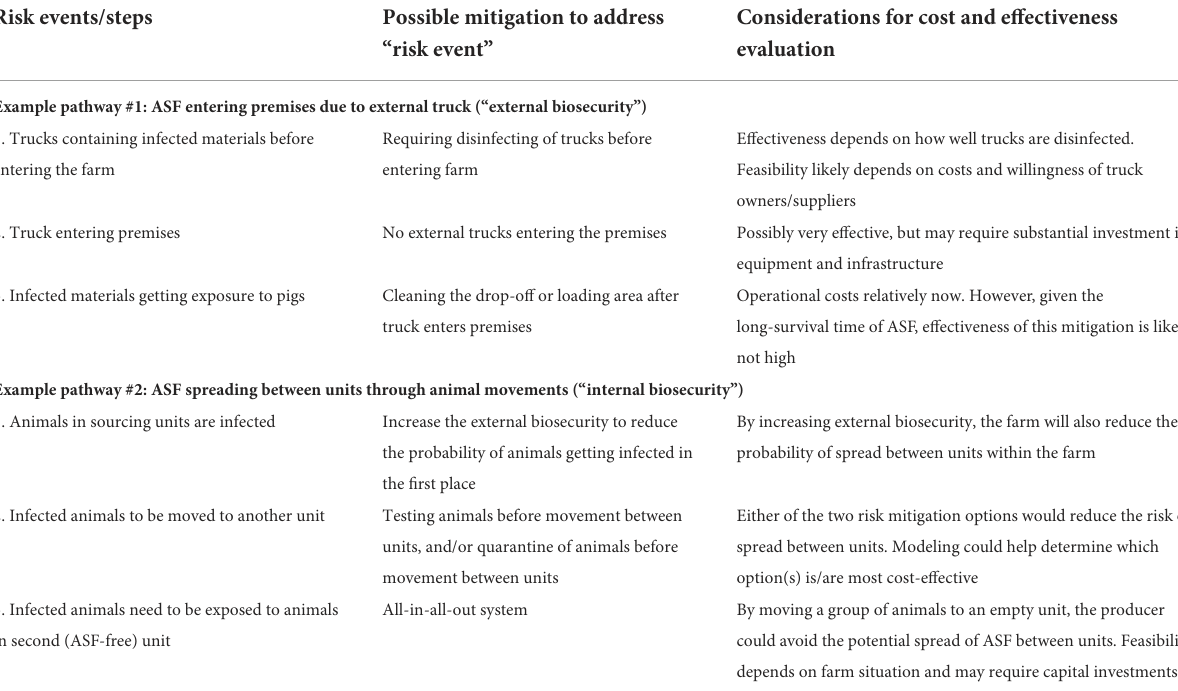
TABLE 1 Evaluation of various fomite-related pathways for introduction of African Swine Fever (ASF) into a hypothetical multi-site commercial sow farm in an endemic environment, indicating, for each of them, areas in which mitigation measures may be implemented. Risk